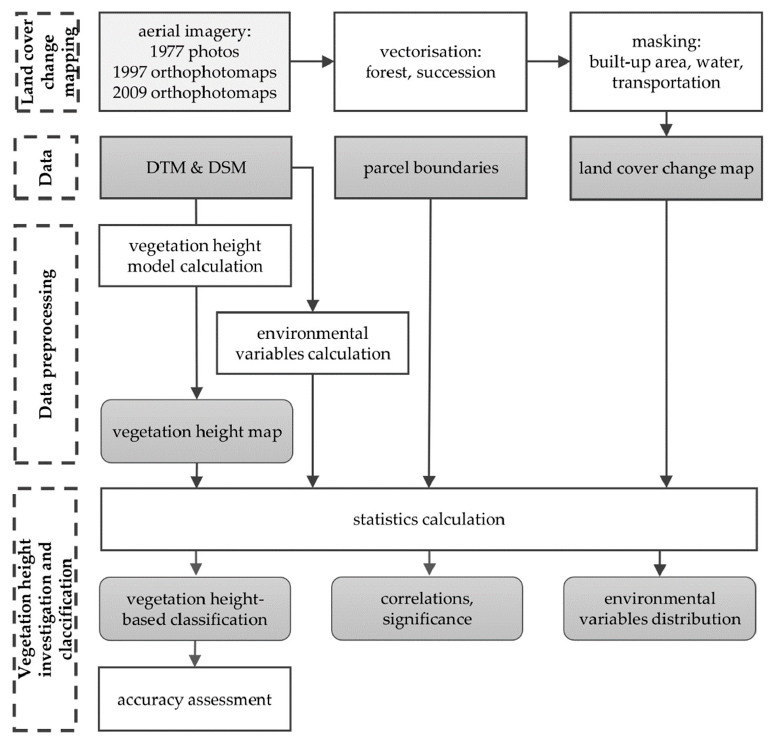
Figure 2. Workflow including land cover change mapping [20] and vegetation height mapping, investigation, and classification. investigation, and